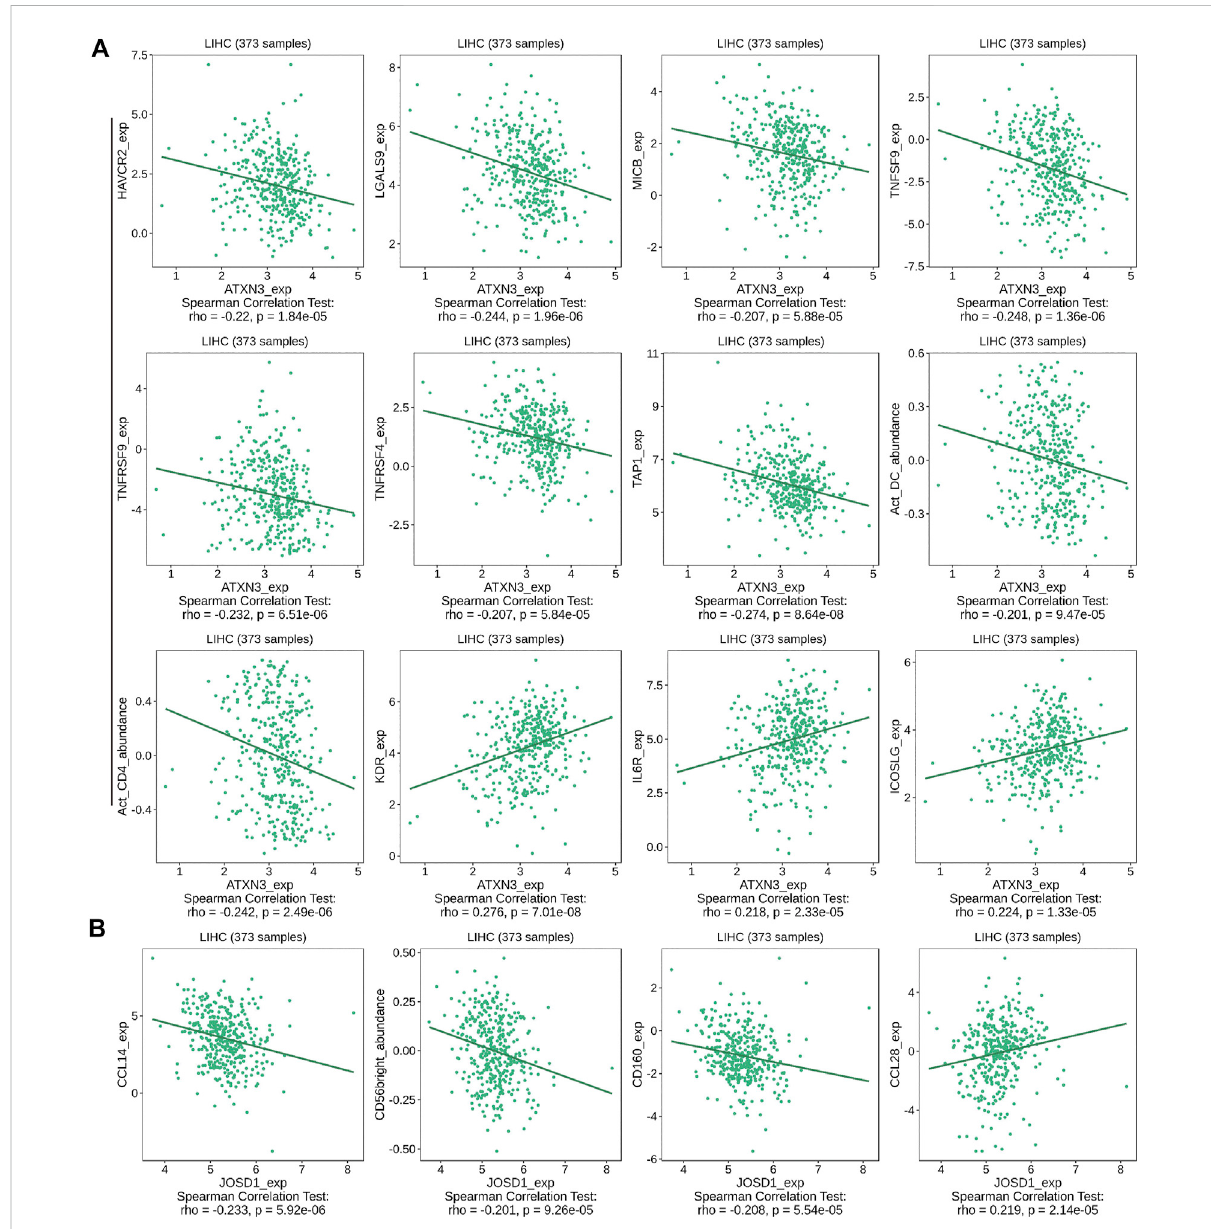
FIGURE 11 Correlation between MJDs level and lymphocytes, immunomodulators, and chemokines expression in HCC from TISIDB database. The correlation between alterations in expression levels of (A) ATXN3, and (B) JOSD1 with the expression of immune cells marker in HCC were